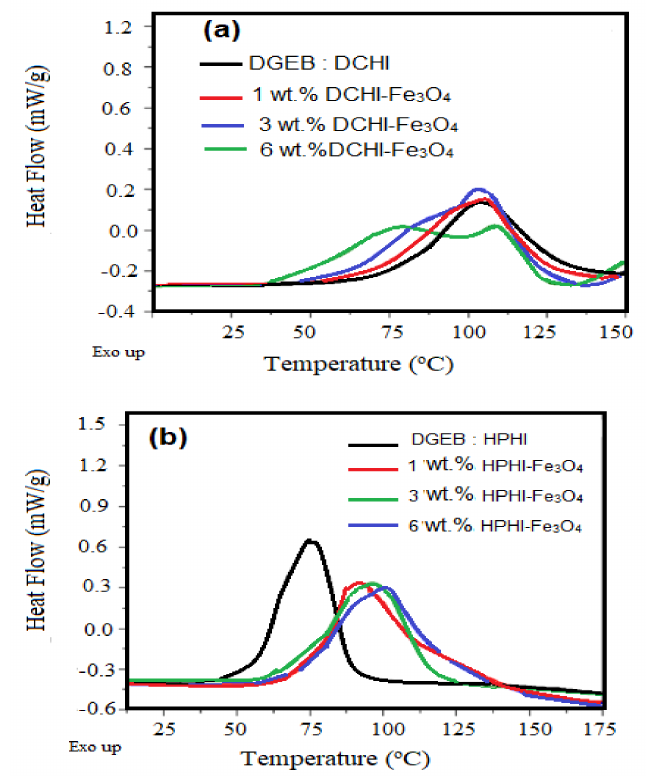
Figure 9. Non-isothermal di ff erential scanning calorimetry (DSC) thermograms of ( a ) DGEB / DCHI and ( b ) DGEB / HPHI and their magnetite